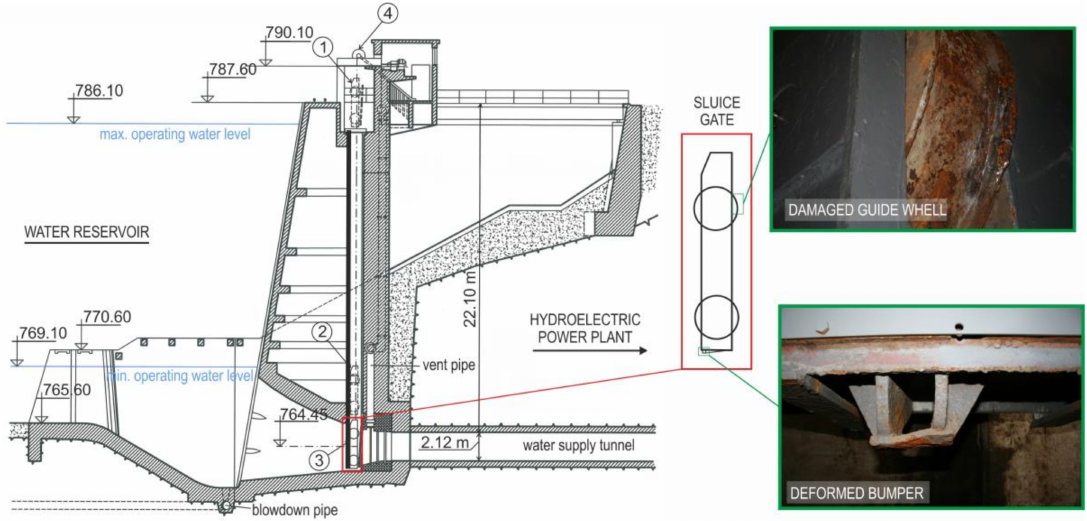
Figure 1. Section of the inlet to the supply tunnel with a deformed contact part of the sluice gate (bumper) and with a damaged part of the sluice gate (guide